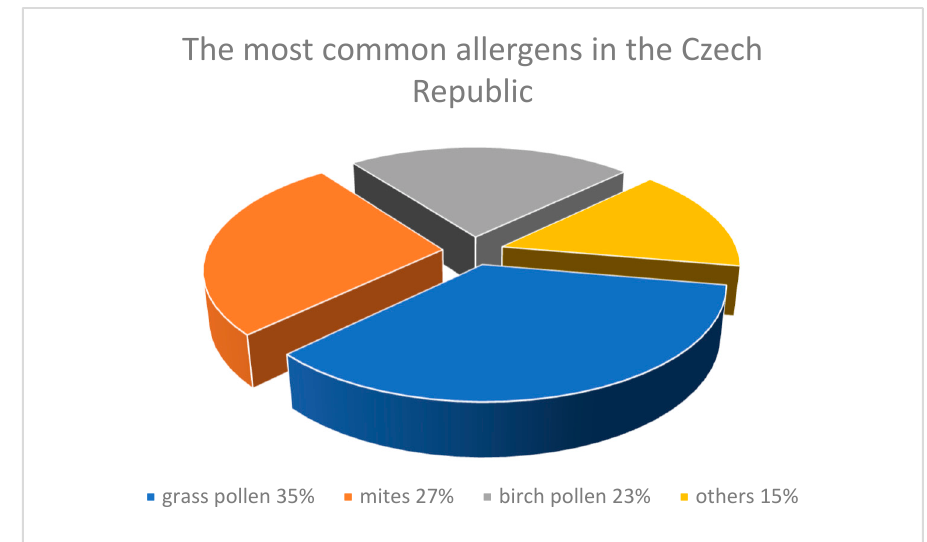
Figure 1. The most common allergens in the Czech Republic [125] .